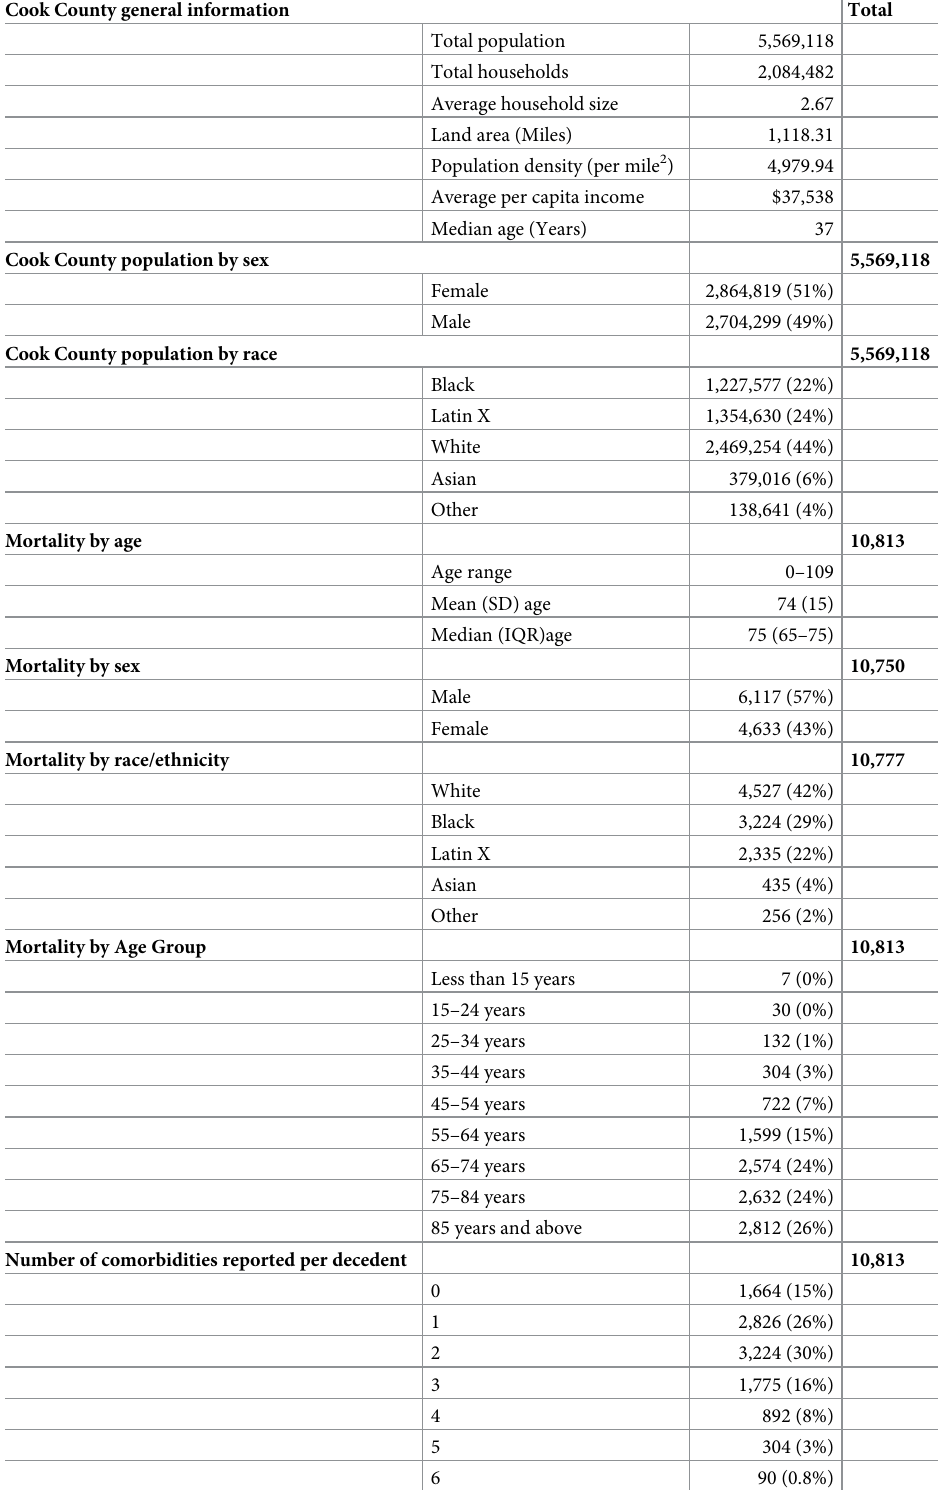
Table 1. Population and COVID-19 mortality, Cook County, March 15-May 31,